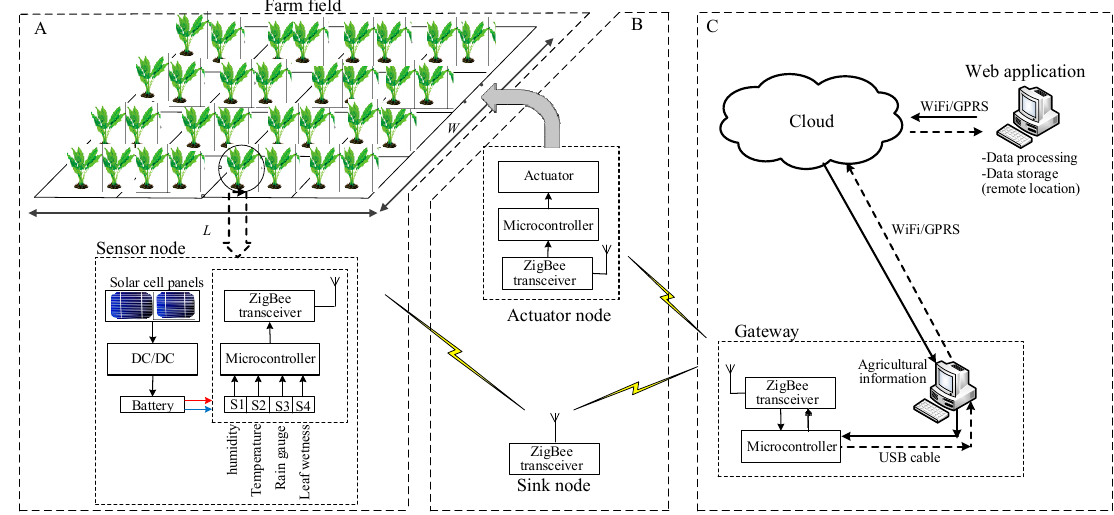
Figure 3. Example of farm field-based Internet of Things (IoT) and provided by a solar cell battery charger: ( a ) Agriculture sensor node with related sensor and solar cell, ( b ) Sink and actuator nodes, and ( c ) Gateway node and cloud computing.